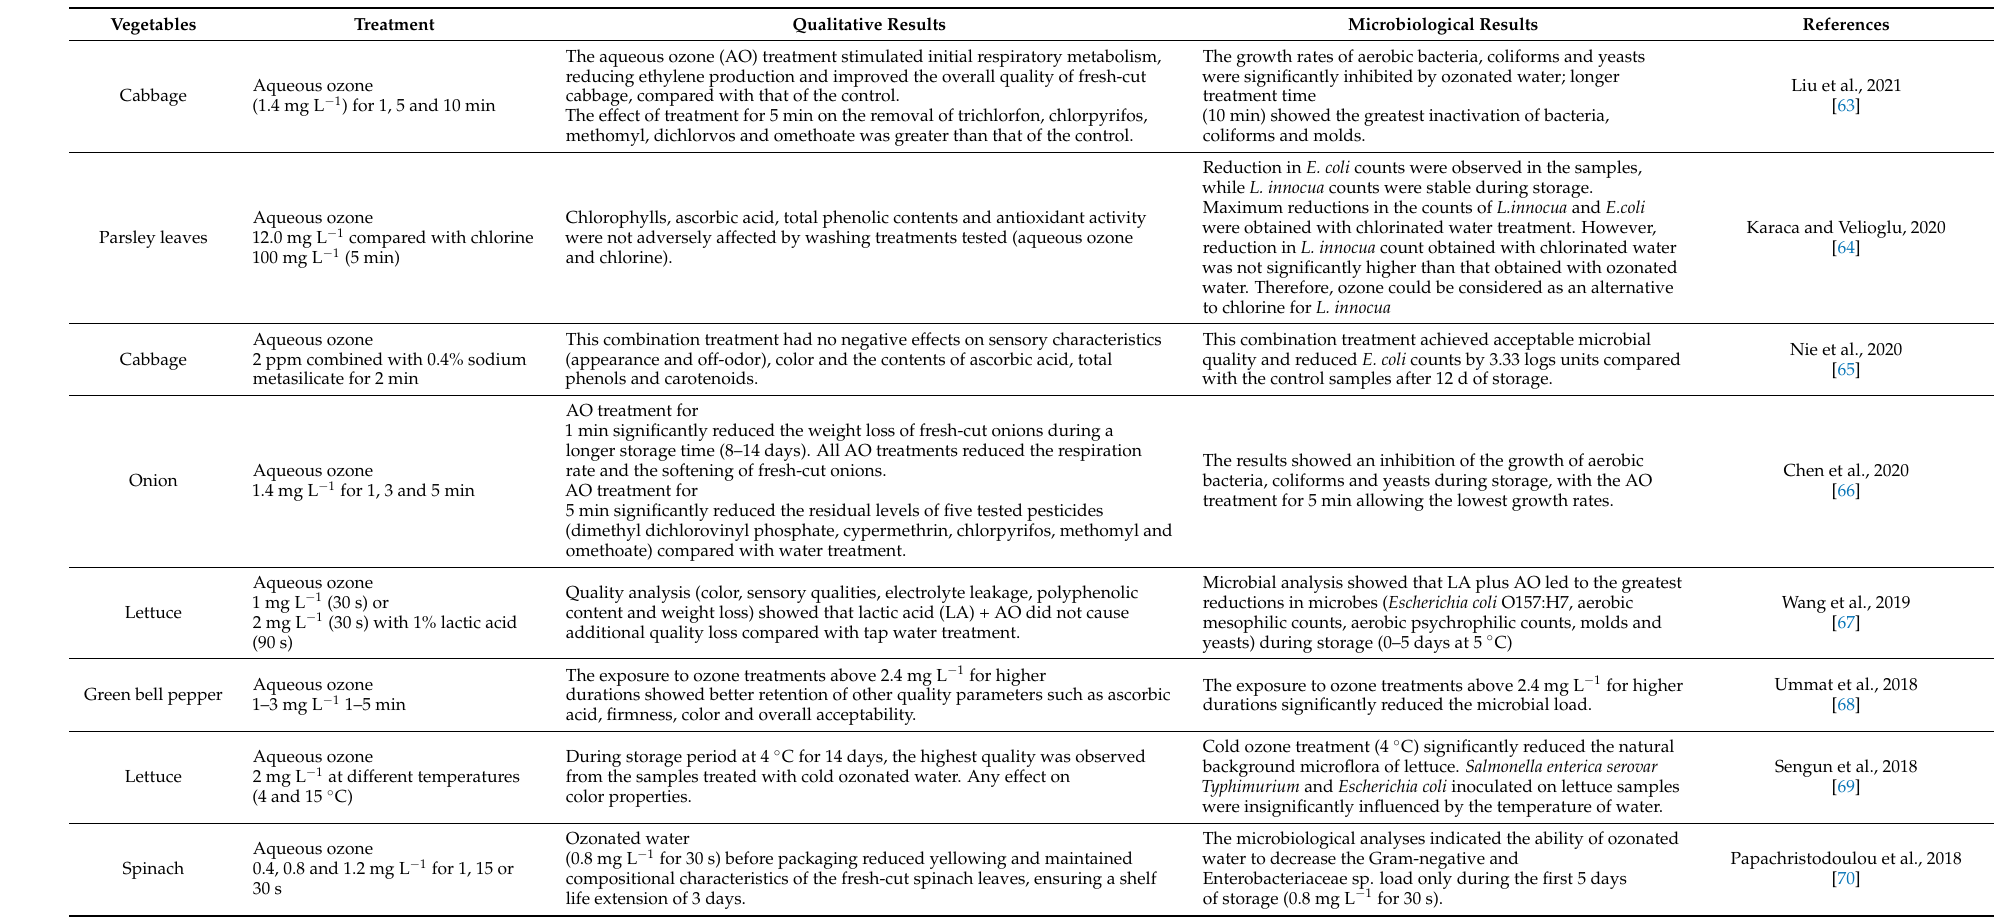
Table 1. Effect on the quality parameters and microbiological control of fresh-cut vegetables treated with aqueous